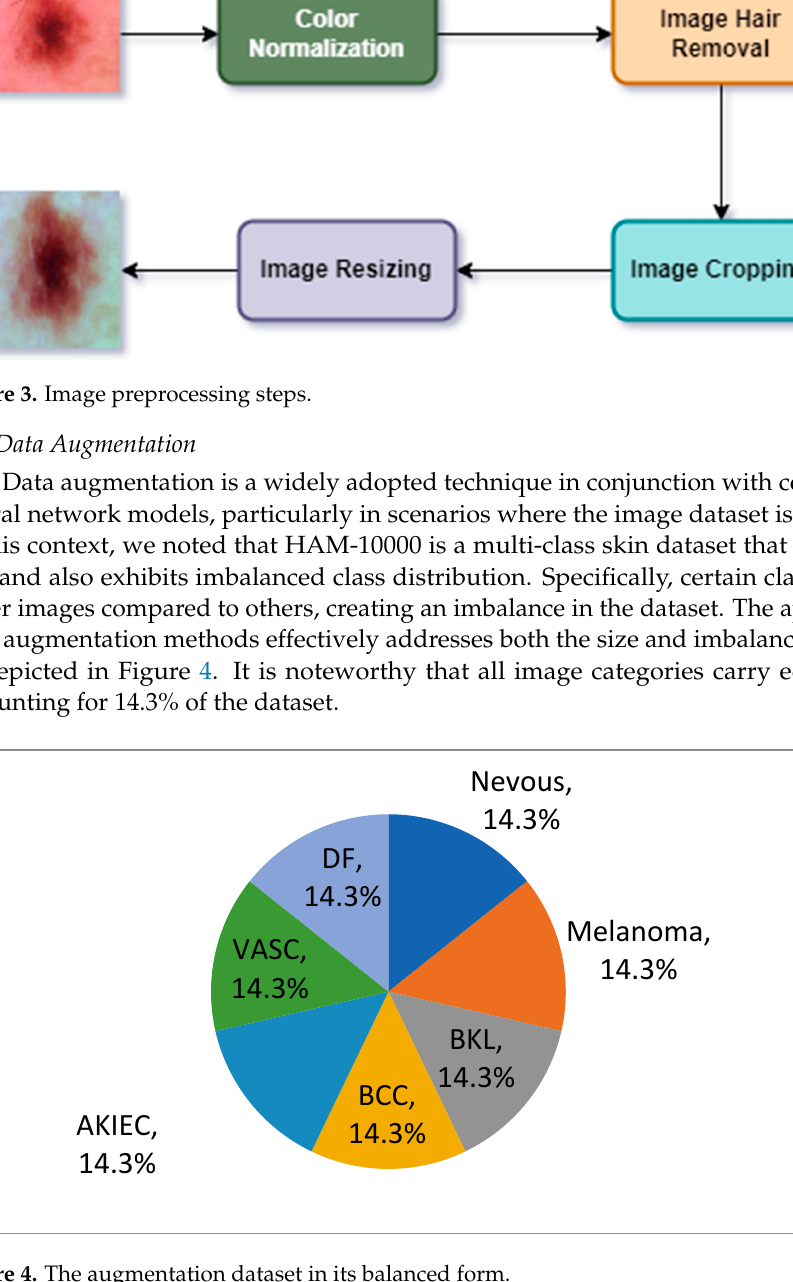
Figure 3. Image preprocessing steps.